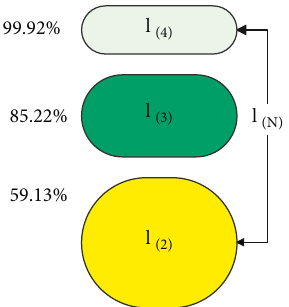
Figure 4: Contribution of each order model.